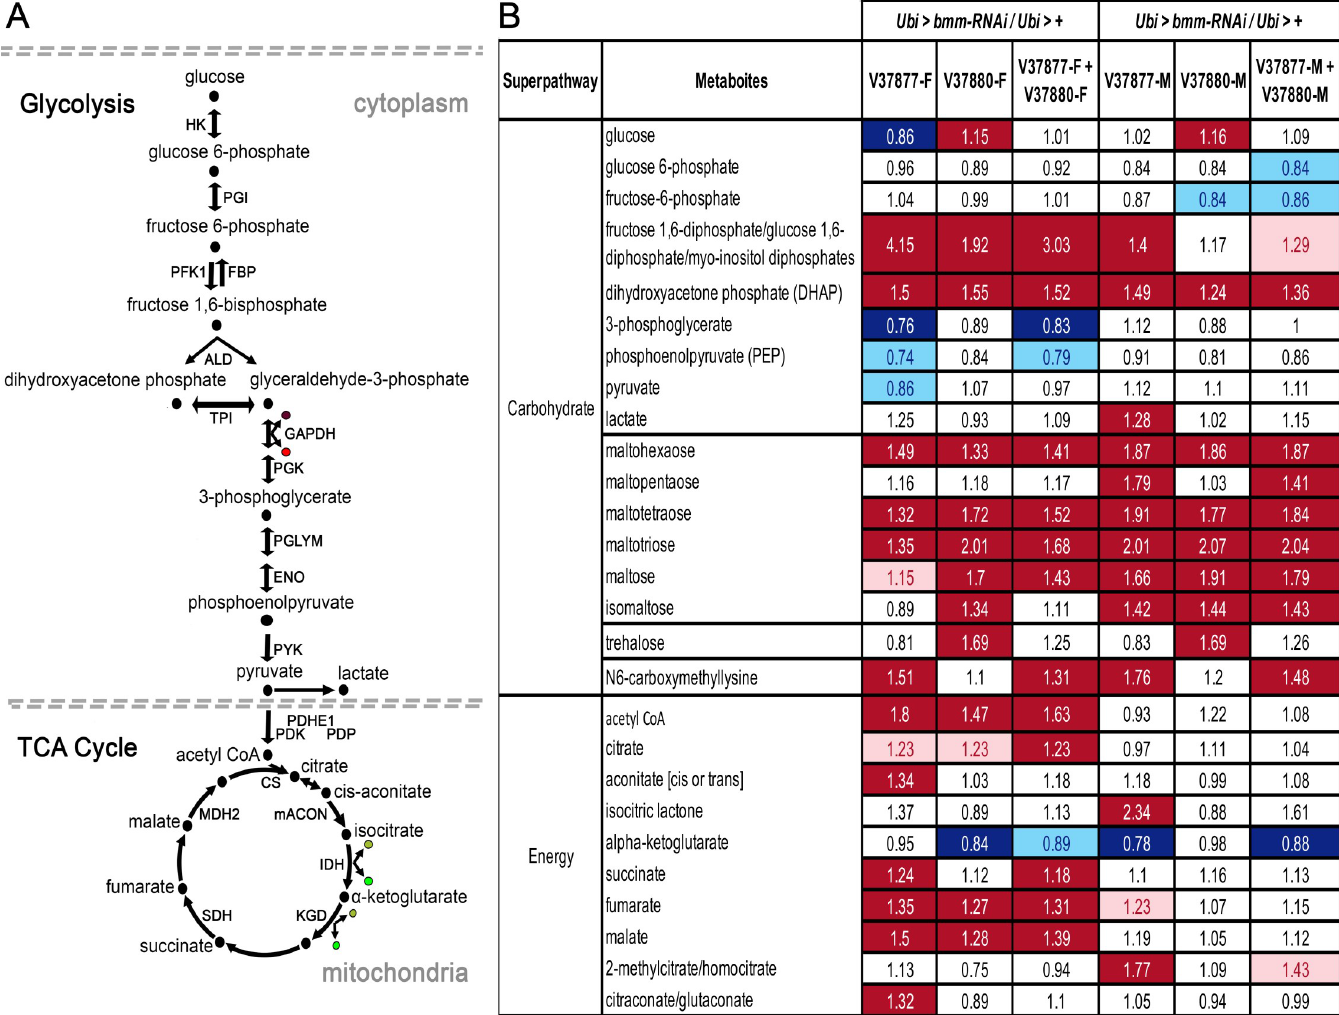
PLOS ONE | https://doi.org/10.1371/journal.pone.0255198 September 21, 2021 12 /